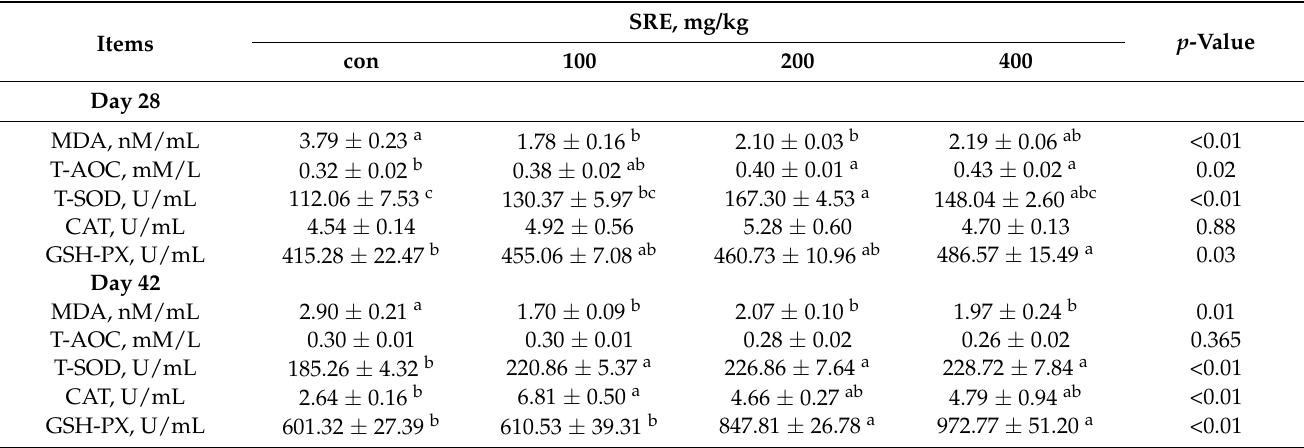
Table 4. Effects of supplementation with stevia residue extract in the diet on the serum antioxidant capacity of weaned piglets on days 28 and 42 of the trial (a)